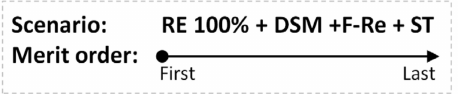
Figure A5. The principle of merit order in the scenario names.